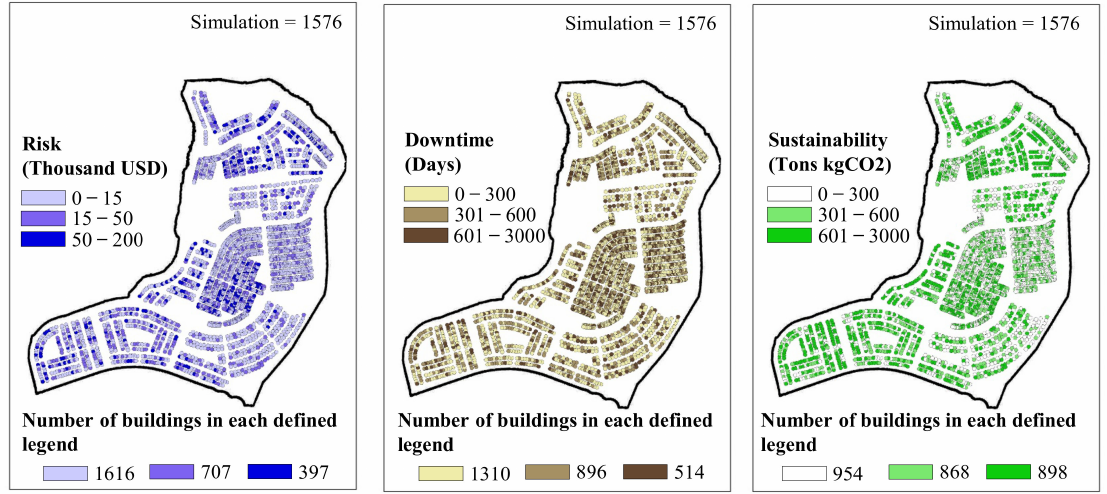
Figure 9. Performance indicators of community building portfolio under a given hazard scenario.